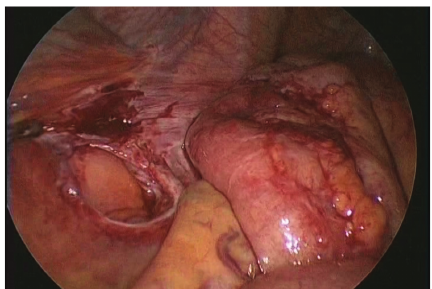
Figure 3: Intraoperative finding 2: the defect in the mesosigmoid was approximately 3 cm. The length of the incarcerated small bowel was approximately 10cm. Redness can only be observed in the bowel.